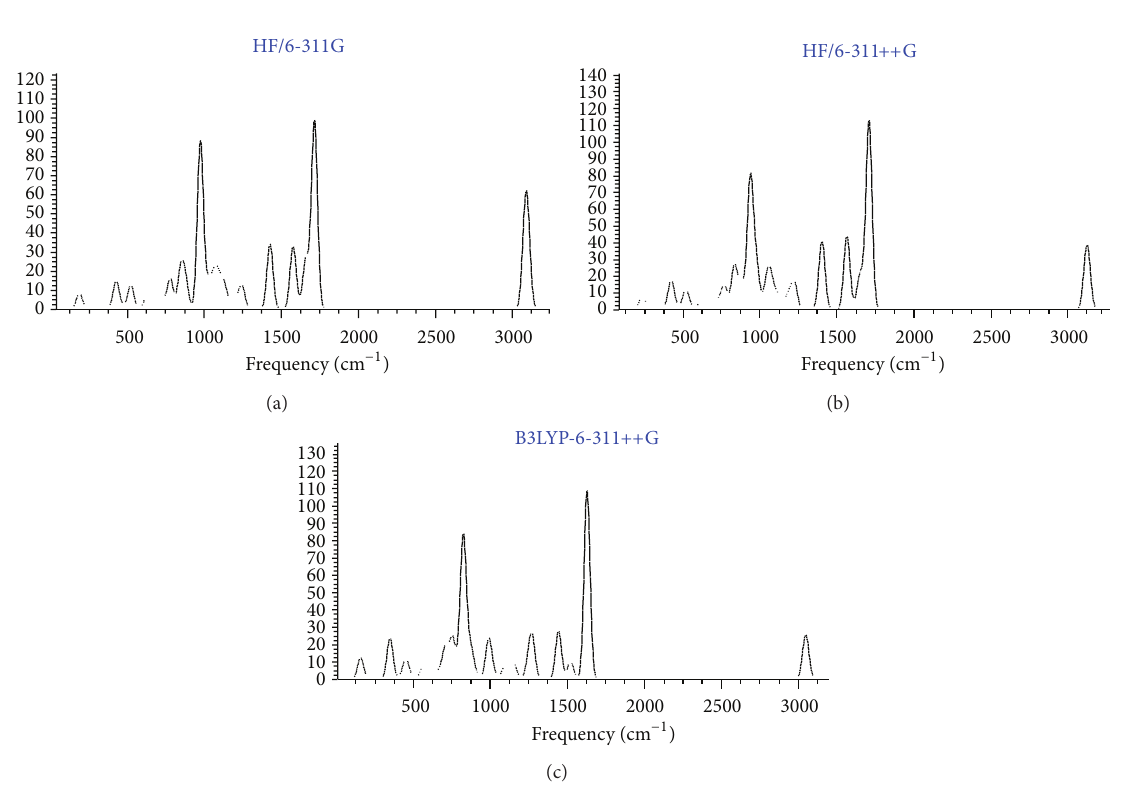
Figure 4: Theoretical FT-IR spectrum of